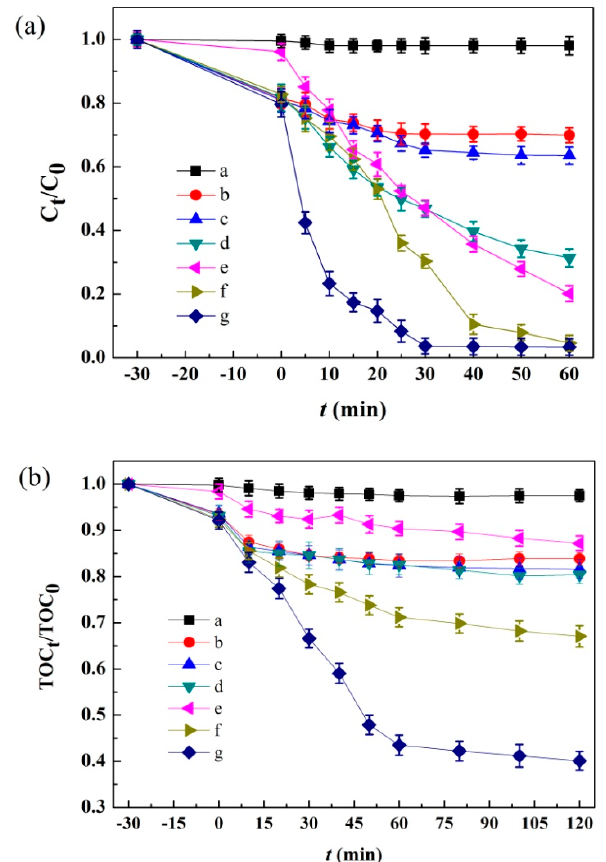
Figure 8. ( a ) Decoloration of MB under different conditions and ( b ) TOC removal of MB under different conditions. a.vis; b.Ag / AgCl / MIL-101(Fe); c.Ag / AgCl / MIL-101(Fe) + H 2 O 2 ; d.vis + Ag / AgCl / MIL-101(Fe); e.vis + H 2 O 2 ; f.vis + MIL-101(Fe) + H 2 O 2 ; g.vis + Ag / AgCl / MIL-101(Fe) + H 2 O 2 ; (pH = 7; [MB] = 10mg / L; [H 2 O 2 ] = 10 mM; catalyst dosage = 1.0 g / L; radiation intensity = 500 W).